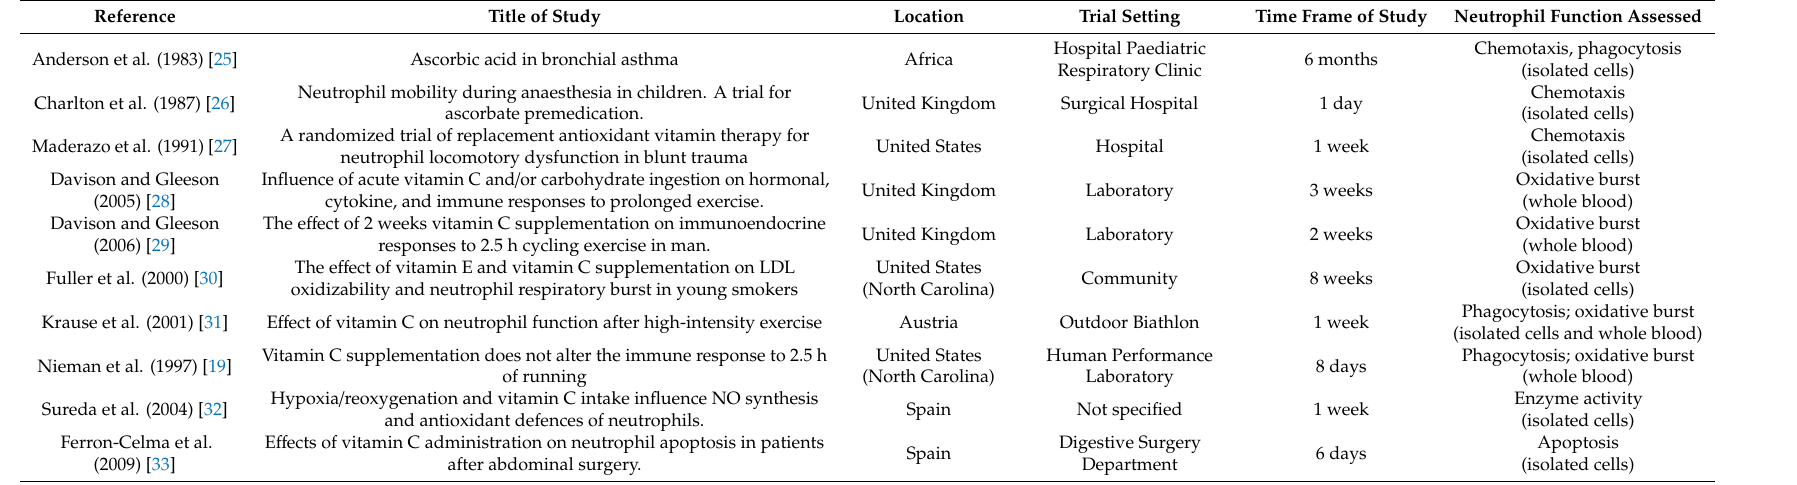
Table 2a. Characteristics of vitamin C-only supplementation studies.